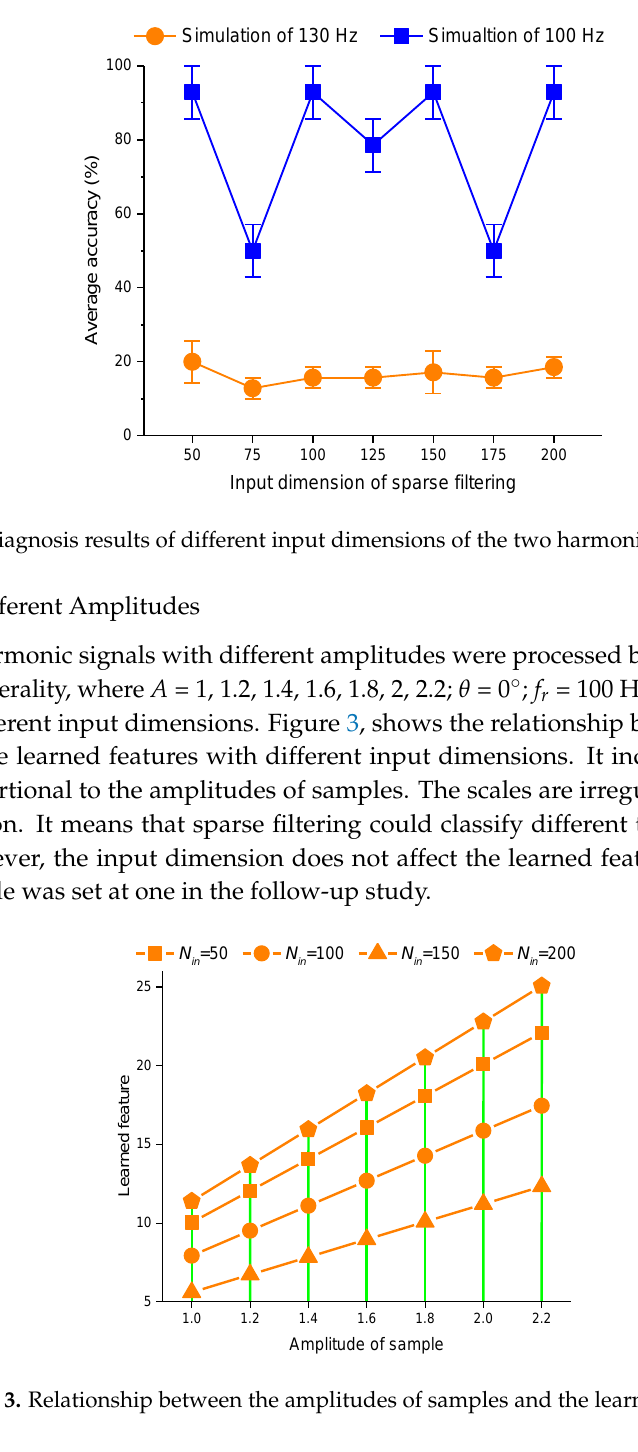
Figure 3. Relationship between the amplitudes of samples and the learned features.